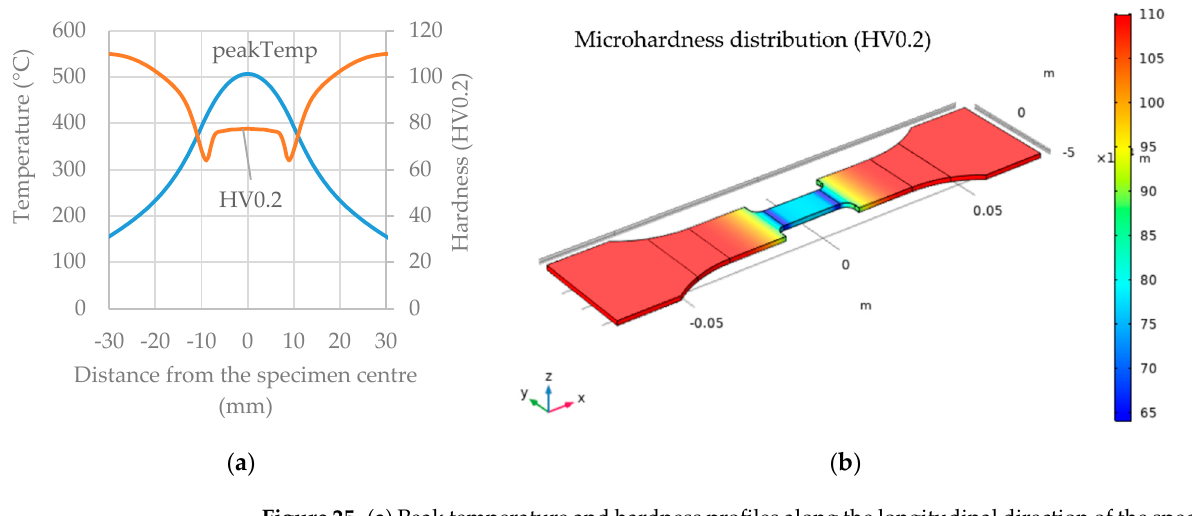
Figure 25. ( a ) Peak temperature and hardness profiles along the longitudinal direction of the specimen (T510V5-T4); ( b ) Microhardness distribution in the tapered specimen (T510V5-T4).